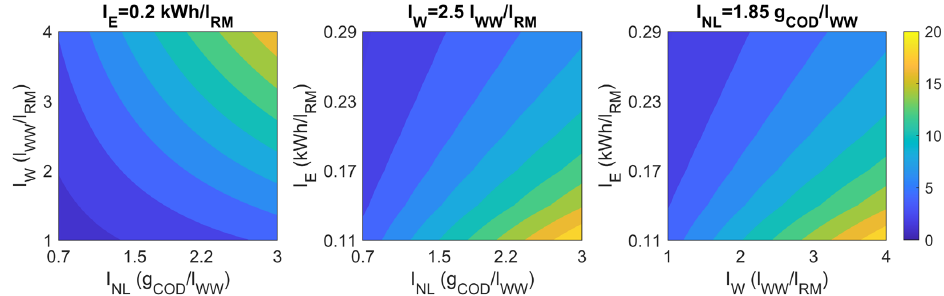
Figure 8. Maps of the energy coverage of biogas production from fluid milk wastewaters.